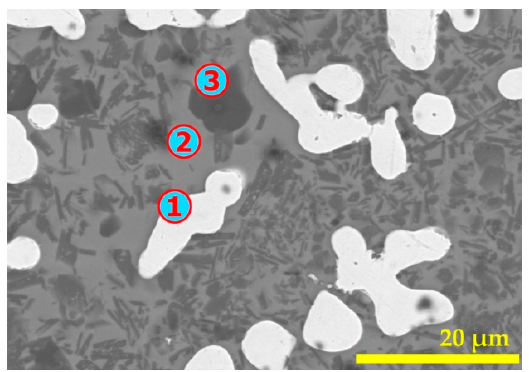
Figure 14. SEM aspects (BSE image) of the pellets treated at 1025 °C for 1 h. The numbers 1 to 3 indicate the locations of microanalysis. Table 2. Elemental composition (EDS data) of the pellets treated at 1025 °C for 1 h.